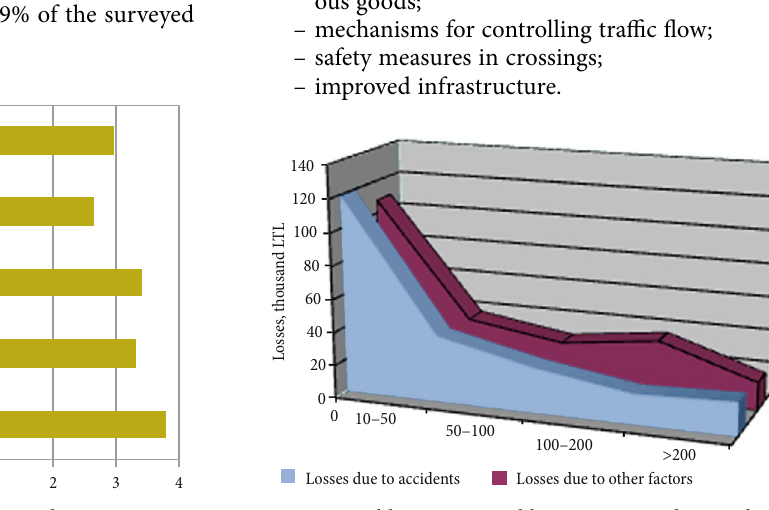
Fig. 5. The averages of risk factor evaluation Fig. 6. Annual losses incurred by enterprises, thousand LTL